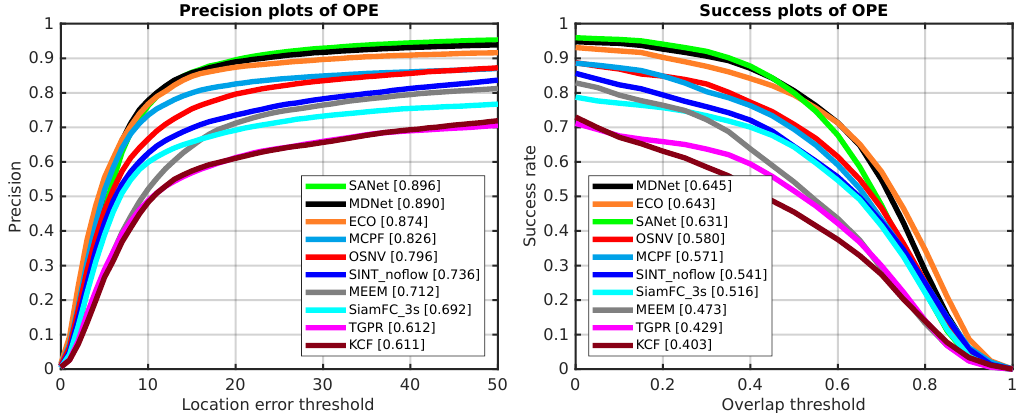
Figure 8. The OPE results of 10 tracking algorithms on OTB-50. The left side is precision plots and the right side is success plots, which are both evaluated on